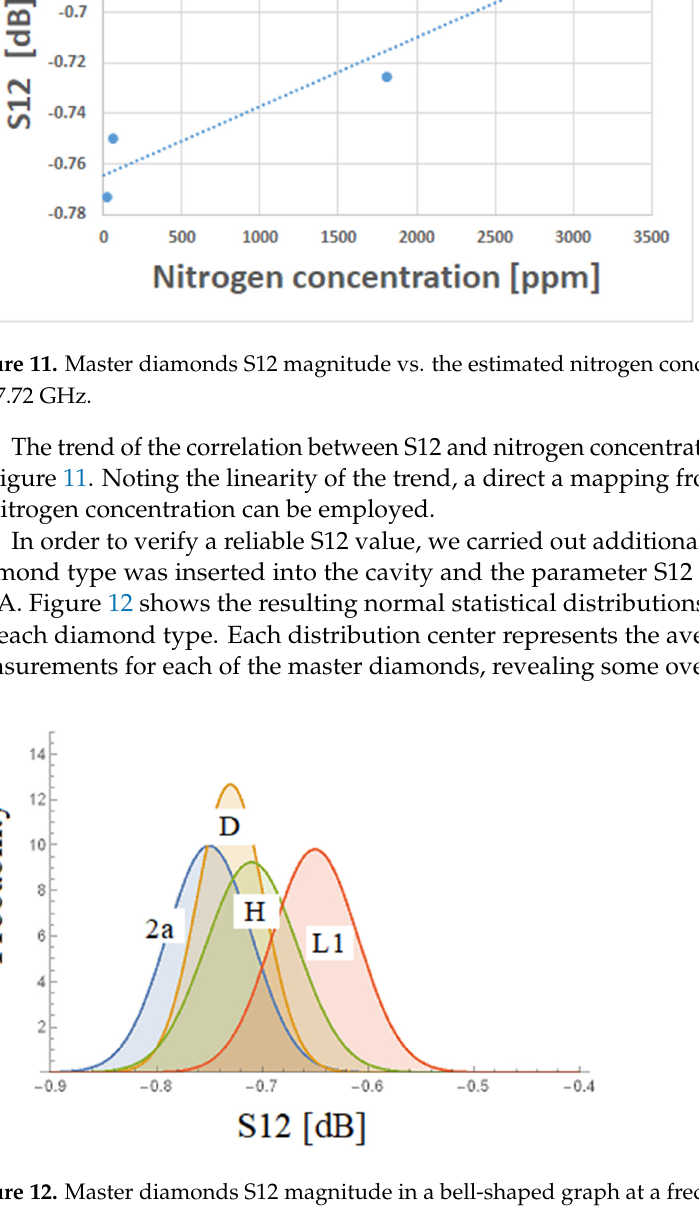
Table 2. Average and STD of S12 at a frequency of 17.72 GHz for the master diamonds. Diamond